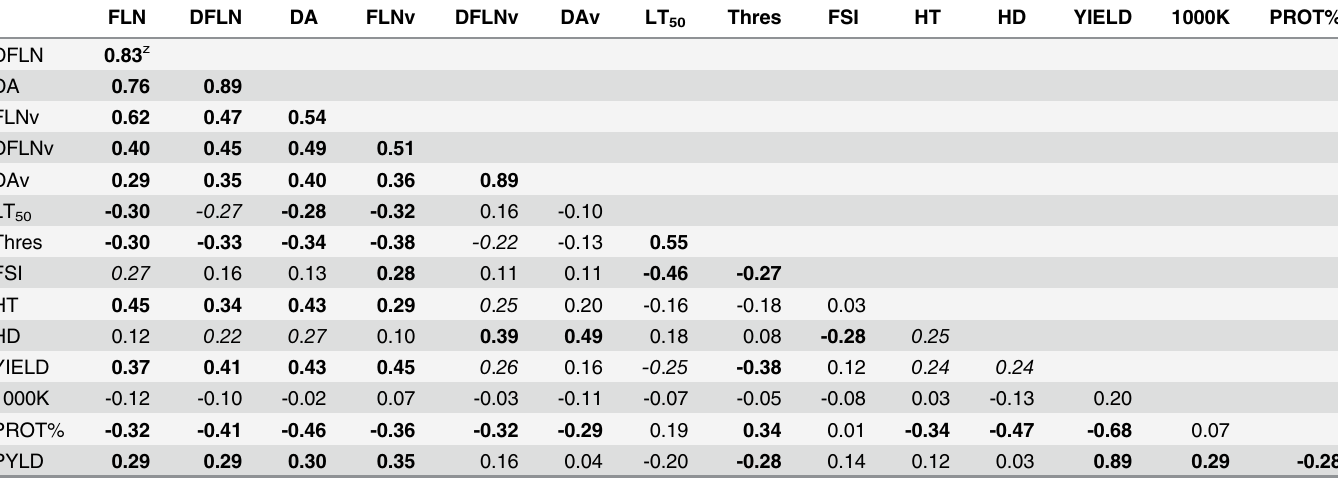
z Signi fi cance of correlation coef fi cient Bold = 0.001, Italics = 0.01, Shaded =